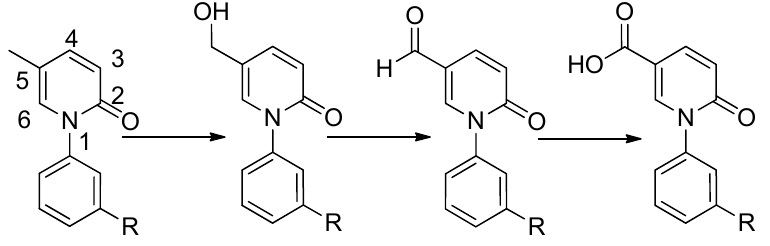
Pirfendone (PFD): R=H Fluorofendone (AKF-PD):